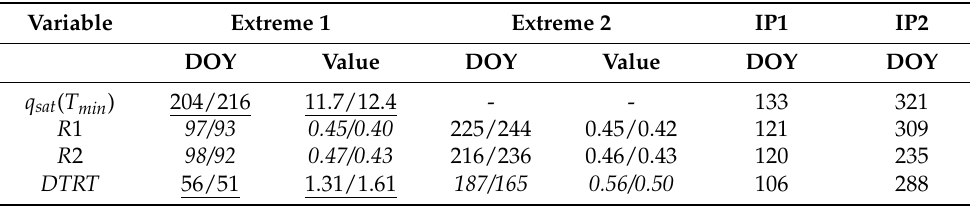
Table 2. Timing of extreme values and inflection points of q sat ( T min ), R 1, R 2 and DTRT at RS climate sta- tion (1990–2020) (note the denotations used in all the following tables: (a) fitted value/measurement- based value; (b) italic—minimum; underline—maximum].